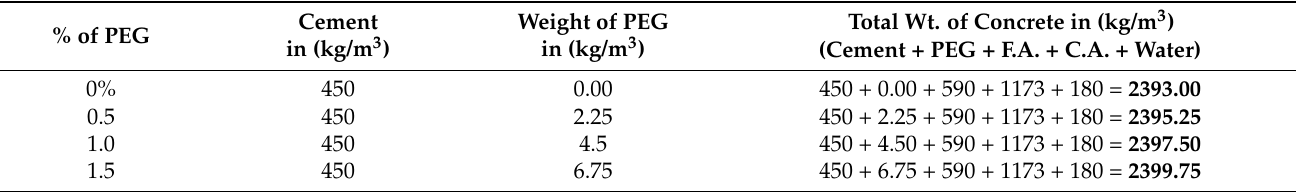
Table 6. Quantity of polyethylene glycol (PEG-600) in various percentages.